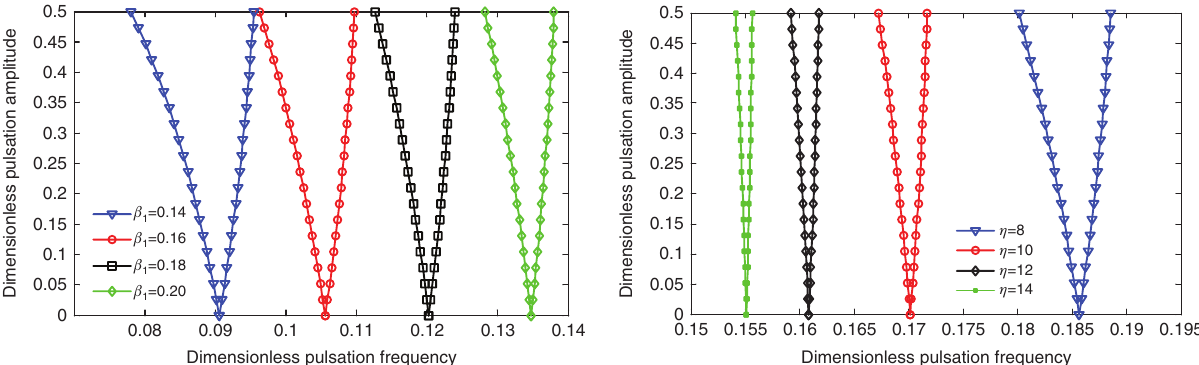
on the dimensionless pulsation amplitude Figure 4: Effect of β 1 versus dimensionless pulsation frequency.